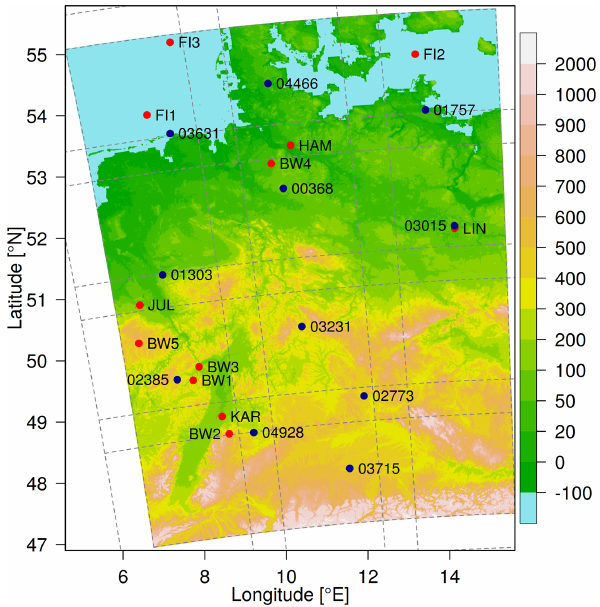
Figure 1. Elevation in the study domain (colors) with observation sites (red dots) and radiosondes (blue dots). Dashed lines indicate subdomains of the diagnostic wind